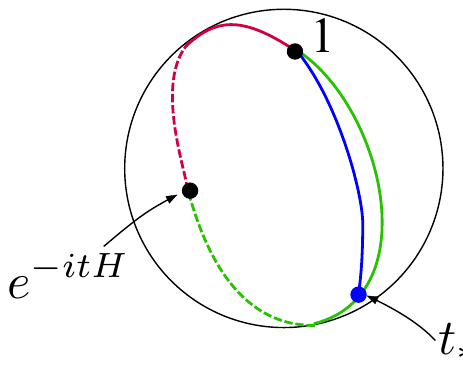
Figure 1 . A cartoon of what happens when a geodesic between 1 and e − itH encounters a conjugate point. The green geodesic is initially the locally minimizing geodesic, before it reaches t ∗ where it encounters a conjugate point (the blue point). For t > t ∗ , the green geodesic is no longer locally minimizing, and a different geodesic (shown in red) will be the local minimum. Note that even though the conjugate point indicates this transition, the new geodesic which takes over after t ∗ is not infinitesimally close to the original one (although we can reach it by gradient flow from the original